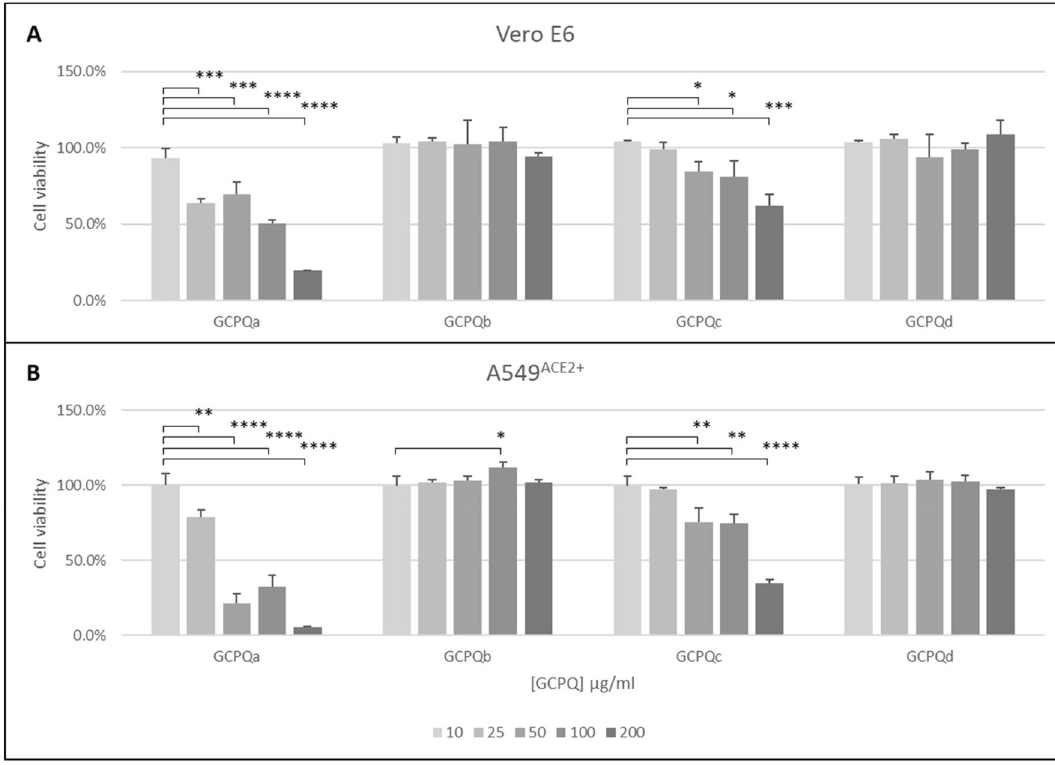
Figure 2. Cytotoxicity of GCPQs in vitro. Cell viability was assessed using an XTT assay on Vero E6 cells ( A ) and A549 ACE2+ cells ( B ). Relative viability of cells (percentage of the untreated control) is shown on y-axis. All assays were performed in triplicate, and average values with standard errors are presented. The letters a to d refer to the GCPQs shown in Table 2. All assays performed in triplicate and analysed by one-way ANOVA with Tukey’s post hoc test. * p < 0.05, ** p < 0.01, *** p < 0.001, **** p < 0.0001.The IC50 values for GCPQa, GCPQb, GCPQc and GCPQd in the Vero E6 cell line are 100 μg/mL, > 200 μg/mL, > 200 μg/mL and > 200 μg/mL respectively. The IC50 values for GCPQa, GCPQb, GCPQc and GCPQd in the A549 ACE2+ cell line are > 25